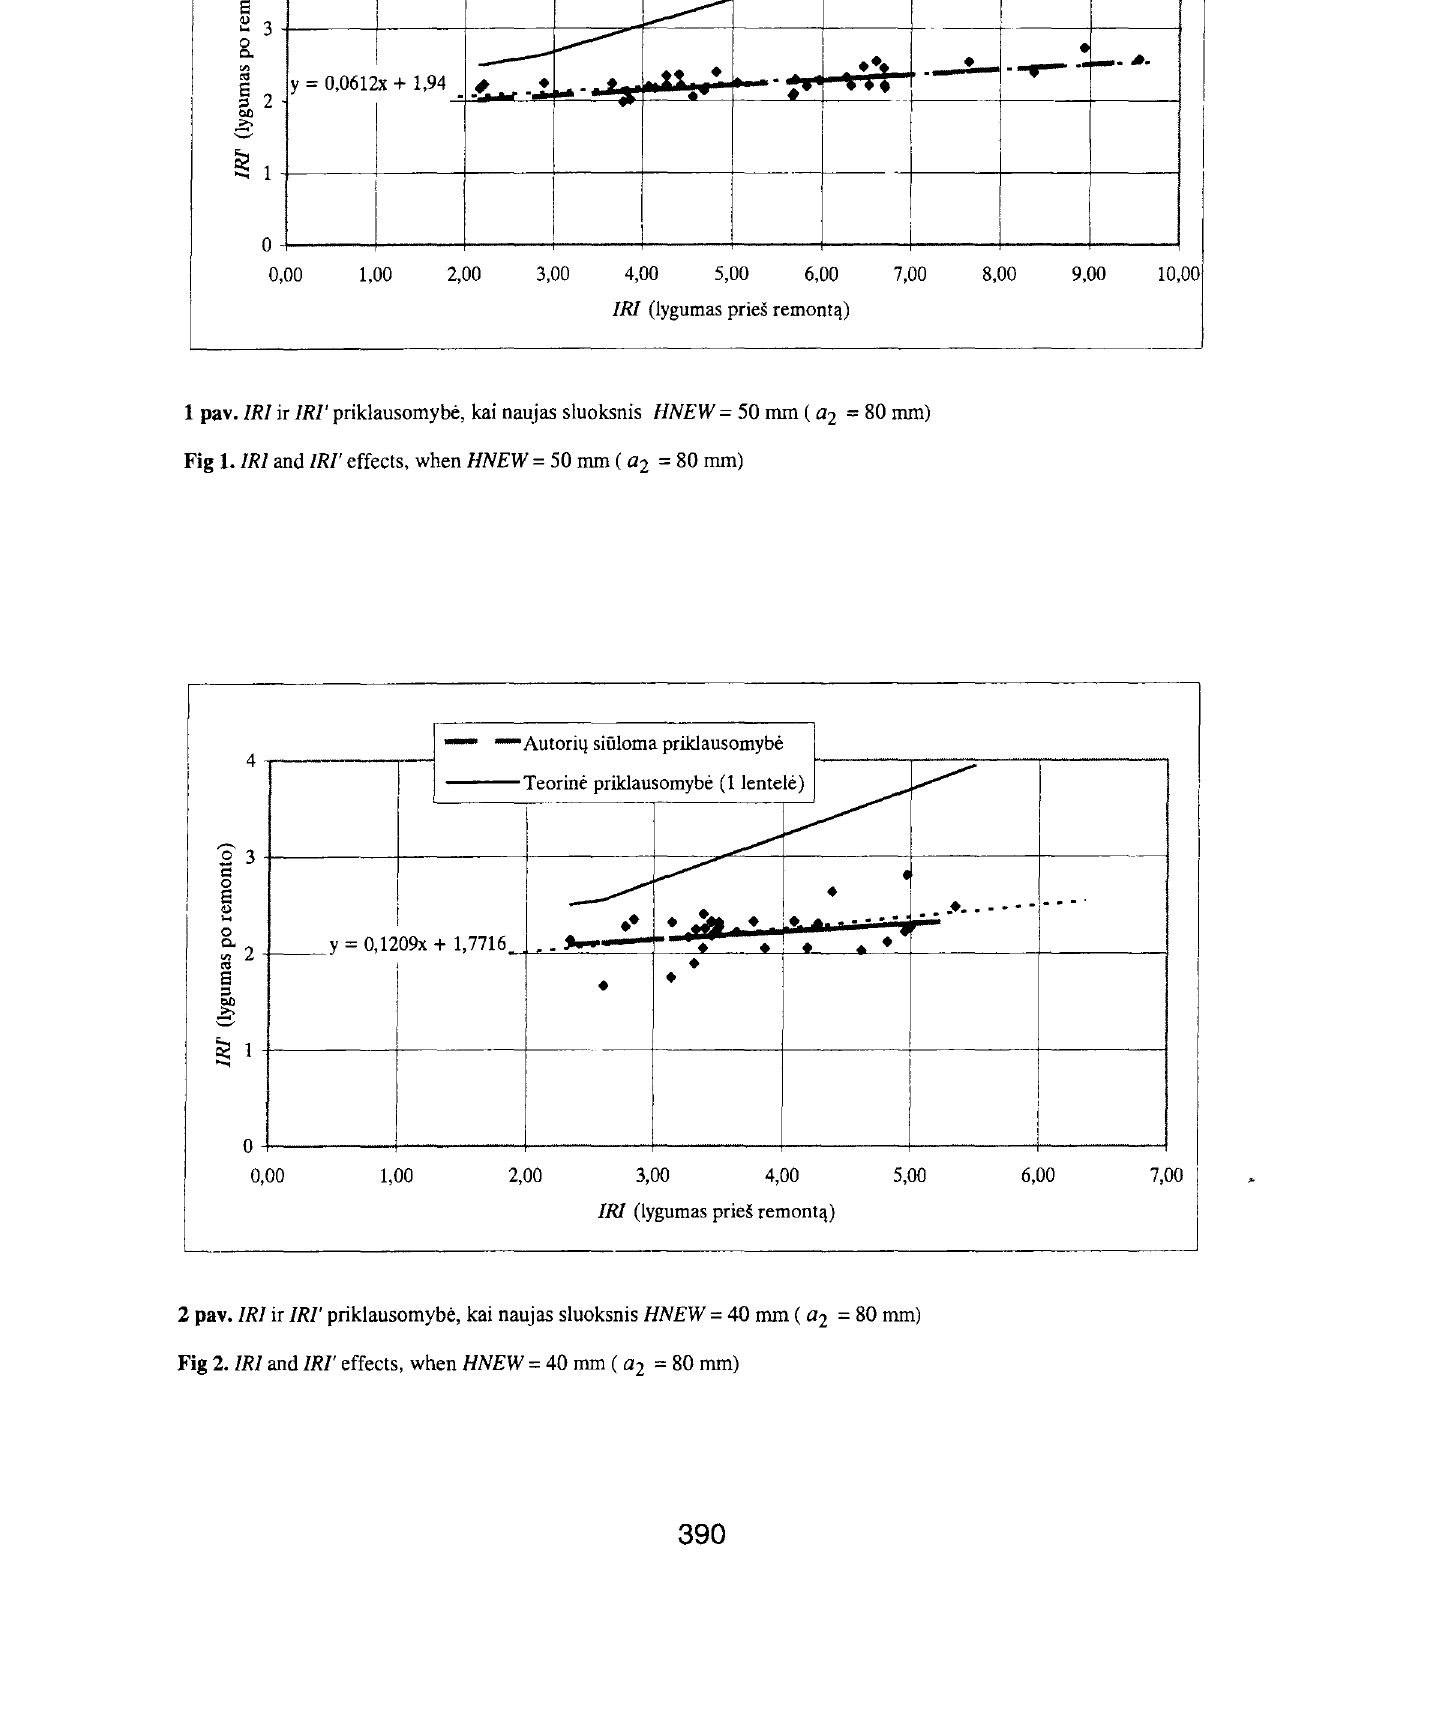
Fig 1. IRI and IRI' effects, when HNEW =50 mm ( a2 = 80 mm)